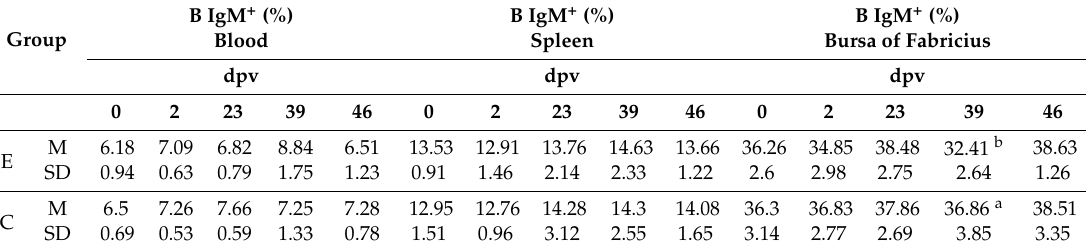
Table 1. The percentage of B IgM + lymphocytes in the blood, spleen, and bursa of Fabricius